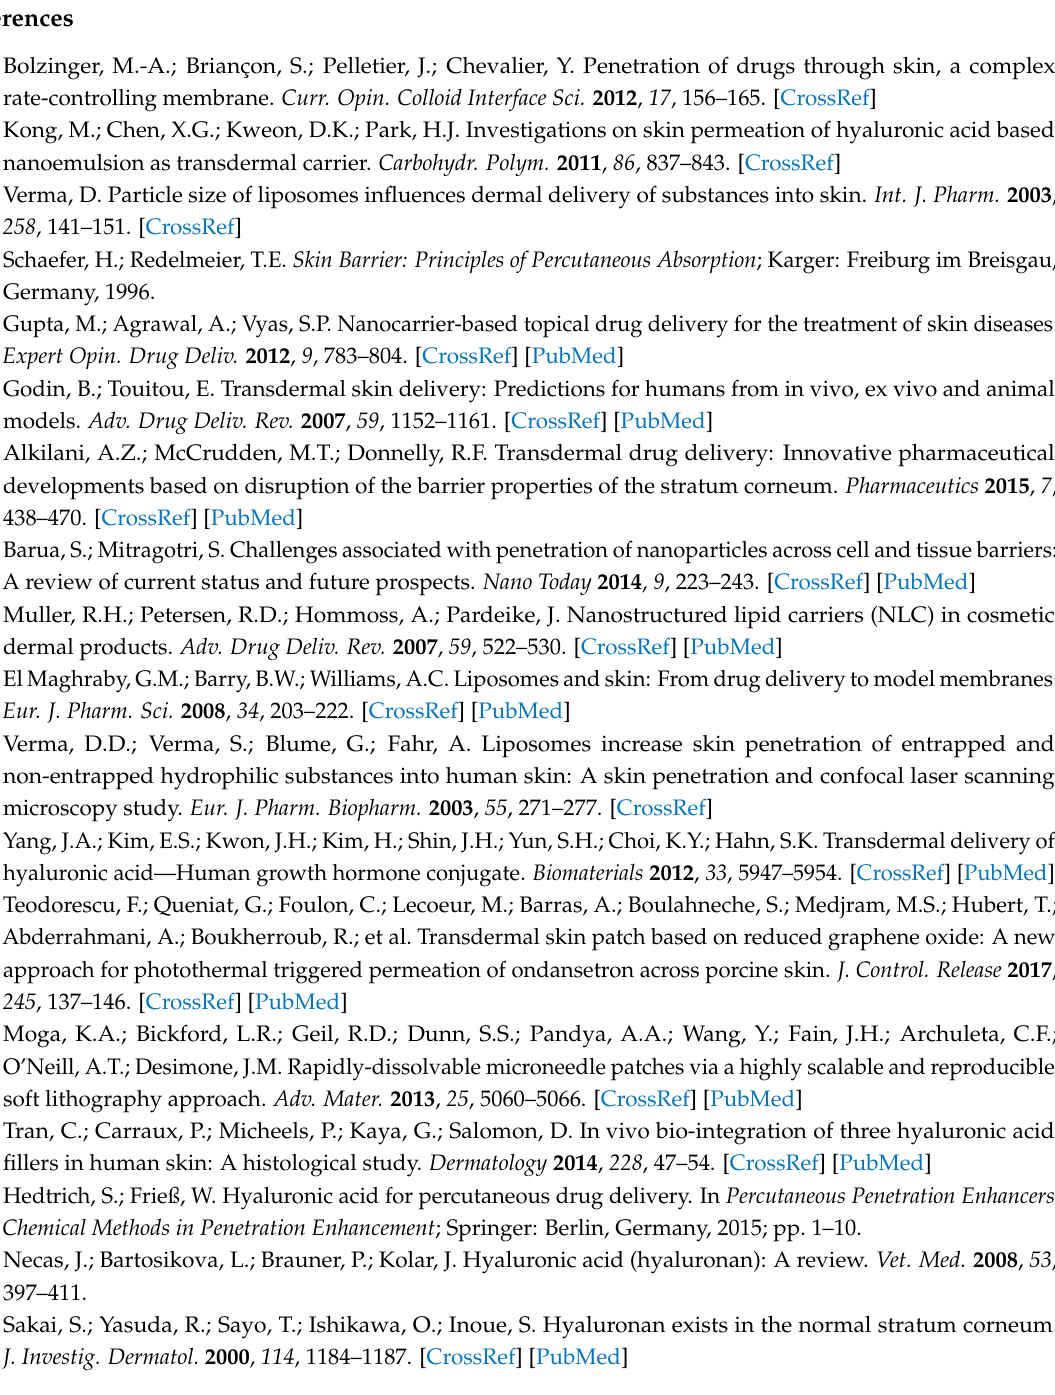
Figure S1: CLSM images of MDA-MB-231 cells incubated with Nanohydrogels for 13 h (left lane: ICG, middle lane: Hoechst and right lane: Merged